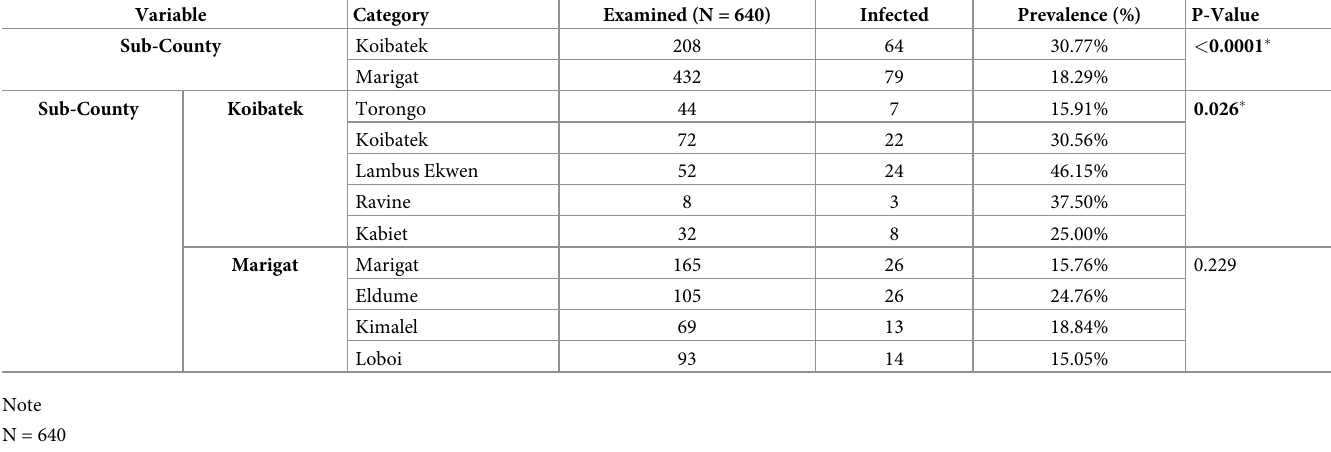
Table 2. Sero-prevalence of brucellosis in domestic ruminants (bovine, sheep, goat and camels) in the locations within Baringo County.